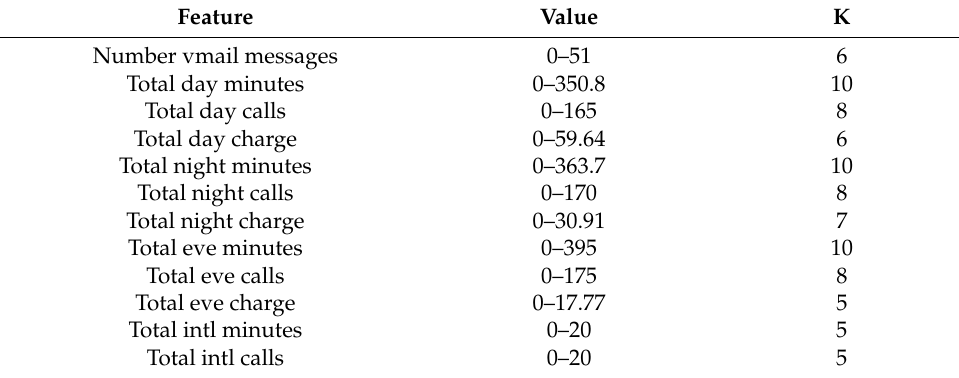
Table 2. Twelve features and values for grouping.